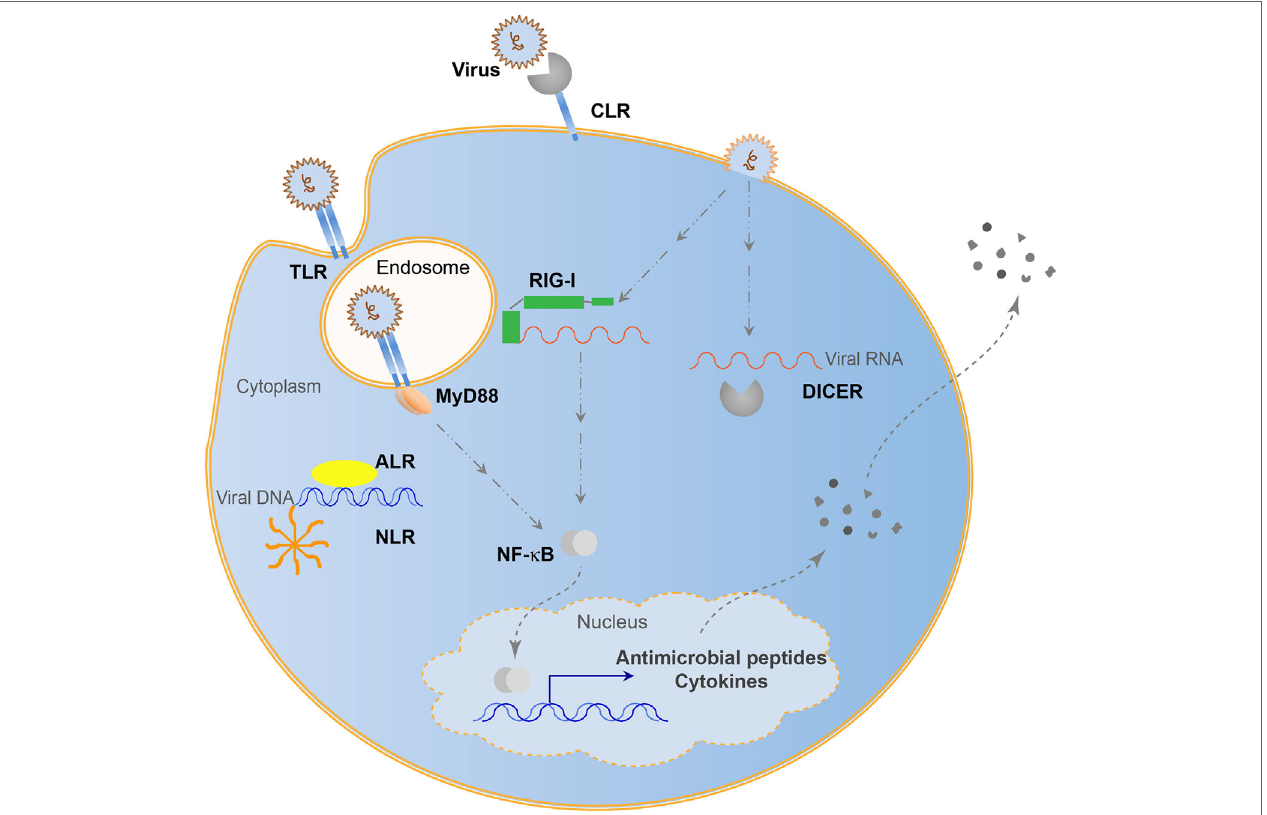
FiGUre 1 | Evolutionarily conserved antiviral innate immune systems. Toll-like receptors (TLRs) recognize endosomal viral nucleic acids, NOD-like receptors (NLRs) form an inflammasome and recognize viral DNA, absent-in-melanoma-like receptors (ALRs) recognize viral DNA, retinoic acid-inducible gene I (RIG-I) and RNAi (Dicer) pathways recognize viral RNA, while C-type lectins (CLRs) recognize viral carbohydrates. Some pathways can lead to the direct elimination of viral entities, while others lead to transcriptional activation resulting in cytokine and antimicrobial peptide